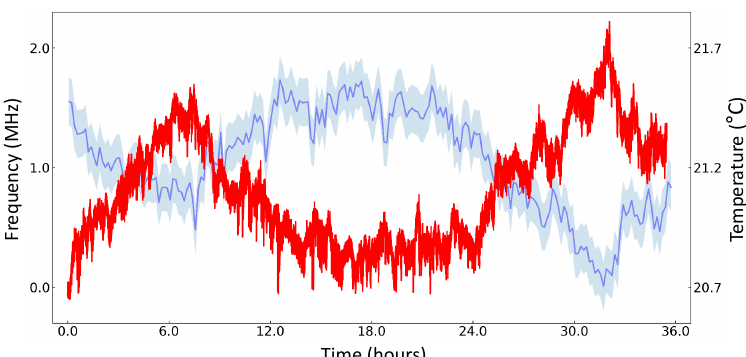
Figure 4. Measurement result of wavelength meter’s frequency drift. Laser frequency, stabilized to a transition of atomic rubidium, is shown in red. Laboratory temperature is shown in blue. Uncertainties of temperature measurement are systematic